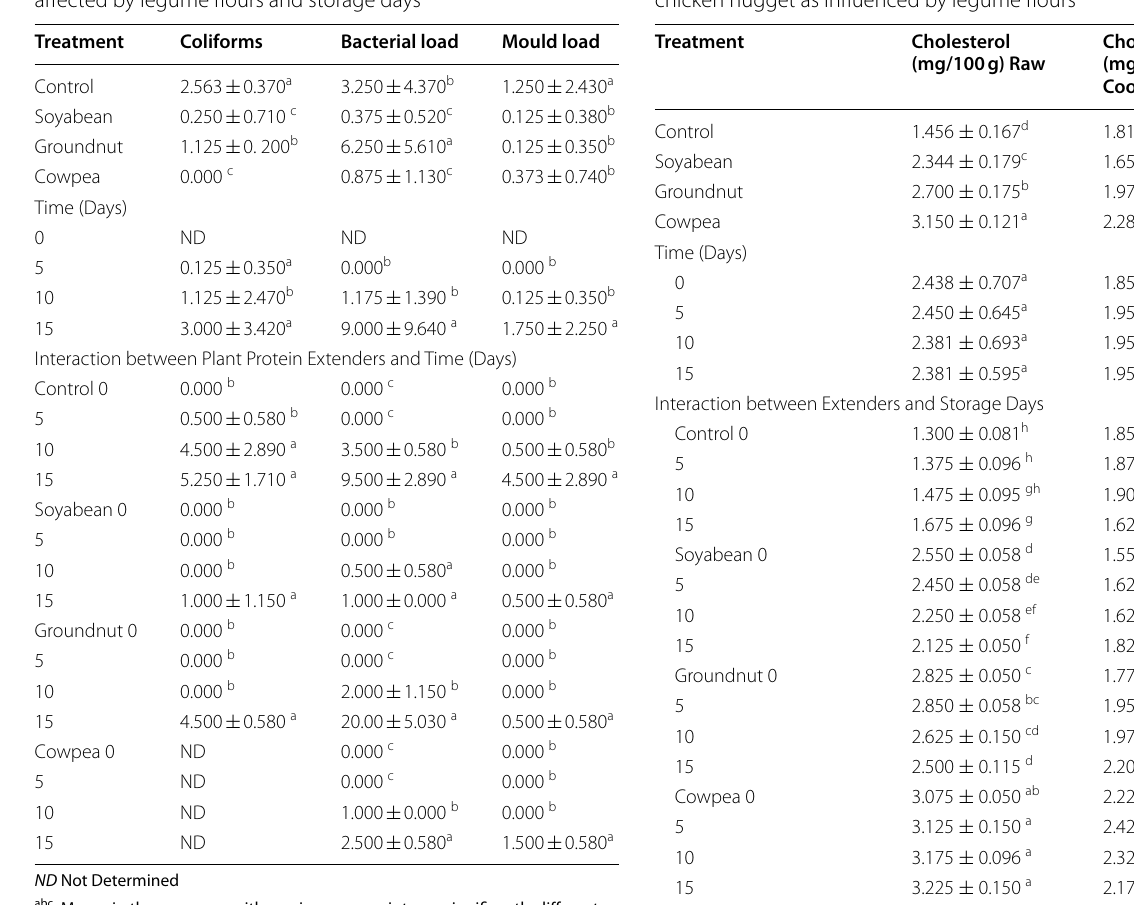
Table 8 Microbial loads (cfu/g 10 3 ) of chicken nuggets as Table 9 Total cholesterol (mg/100 g) of raw and cooked broiler × affected by legume flours and storage days chicken nugget as influenced by legume